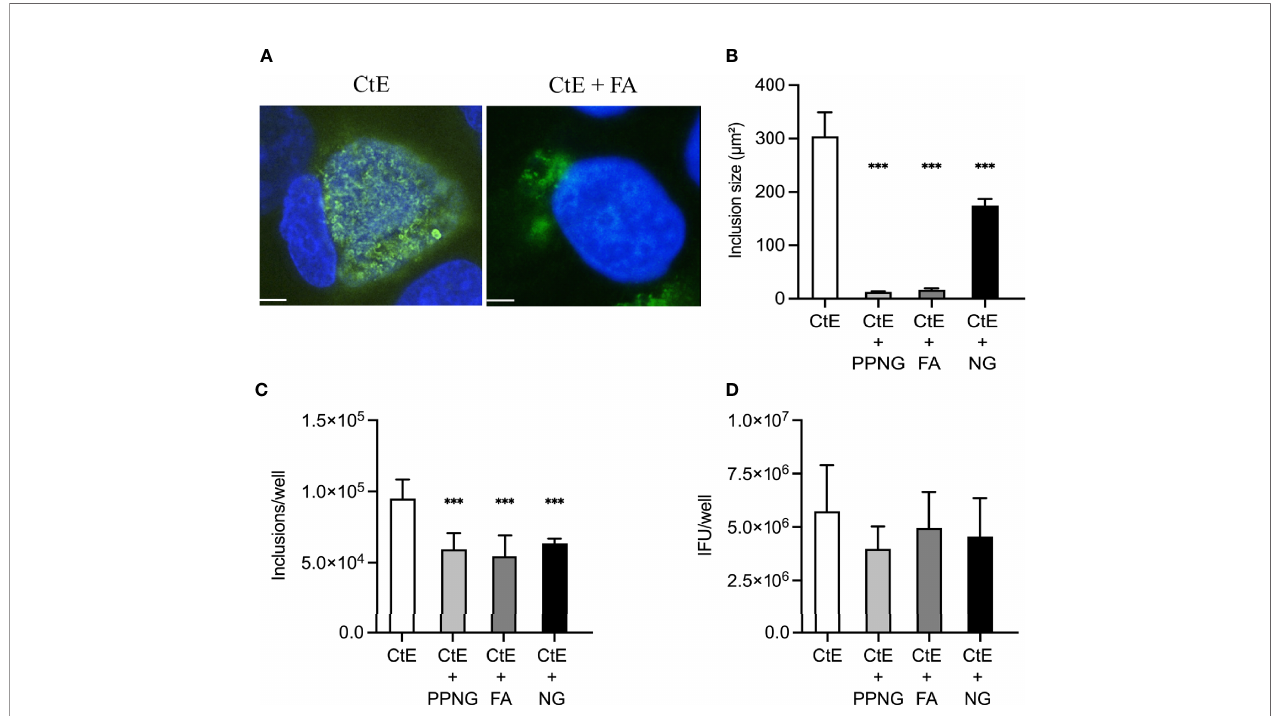
FIGURE 3 | Ng infection immediately after CtE infection limits chlamydial inclusion development. HeLa cells were exposed to cycloheximide-supplemented culture medium (no Ng) for 24 h prior to subsequent CtE infection. Immediately after CtE infection, cells were infected with Ng (minimum CFU inocula required for growth in culture medium) in fresh cycloheximide-supplemented culture medium ( Figure 1B ). Cycloheximide-supplemented culture medium was refreshed at 20 h post-CtE infection and samples were processed for IF analysis of inclusion formation/development or determination of infectivity (IFU/well) at 40 h post-CtE infection. Representative micrographs (A) of CtE (left) and CtE + FA (right) experimental groups, CtE inclusion size (B) (expressed as inclusion area, m m 2 ), CtE inclusions/well (C) , and CtE IFU/well (D) are shown. Scale bars = 5 µm; DAPI staining of DNA is indicated in blue and LPS immunolabeling of CtE is indicated in green. Signi fi cant differences from the control are indicated with asterisks: * p < 0.05, ** p < 0.01, *** p <